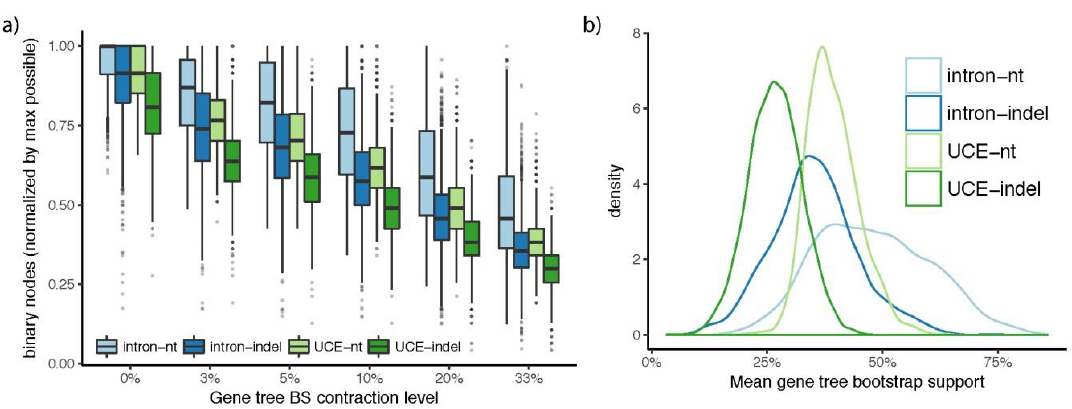
Figure 5. Gene tree resolution for intron and UCE gene trees estimated from indel and nt data. ( a ) Boxplots show the number of binary nodes, normalized by the maximum possible number of binary nodes (e.g., 46 for gene trees with no missing data) for gene trees where nodes with BS up to a certain threshold (x-axis) are contracted. With no contraction, this value is 1.0 and with increased filtering, it quickly drops; ( b ) The density of the gene tree BS averaged over all branches of each gene tree are shown. Overall, nt gene trees are better supported than indels and introns are better supported than UCEs.